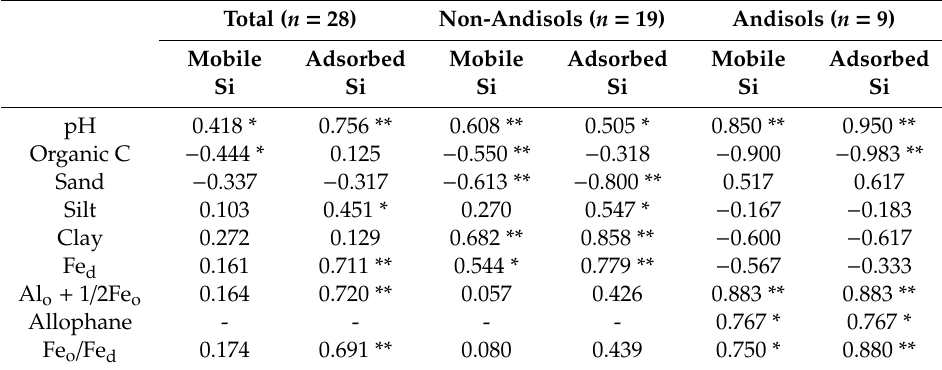
Table 4. Spearman’s rank correlation between readily soluble Si fraction (mobile Si and adsorbed Si) and selected physicochemical properties of the